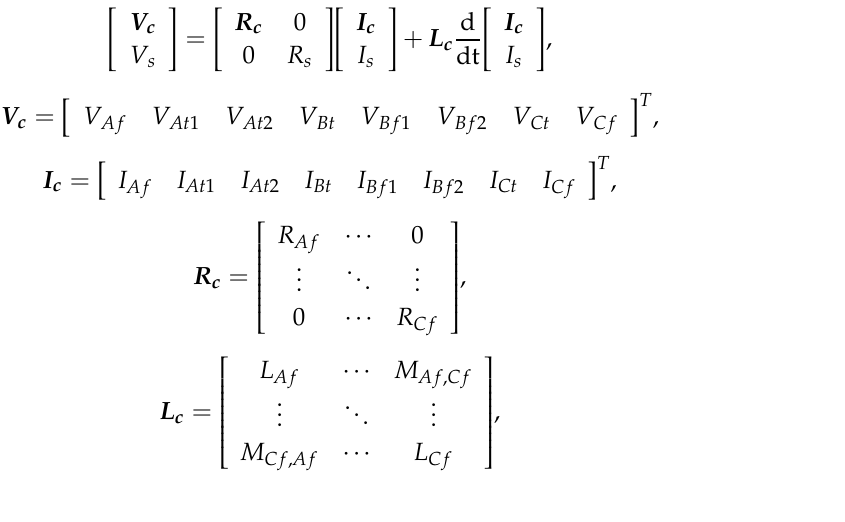
Figure 3. The equivalent circuit of the HTS power cable.